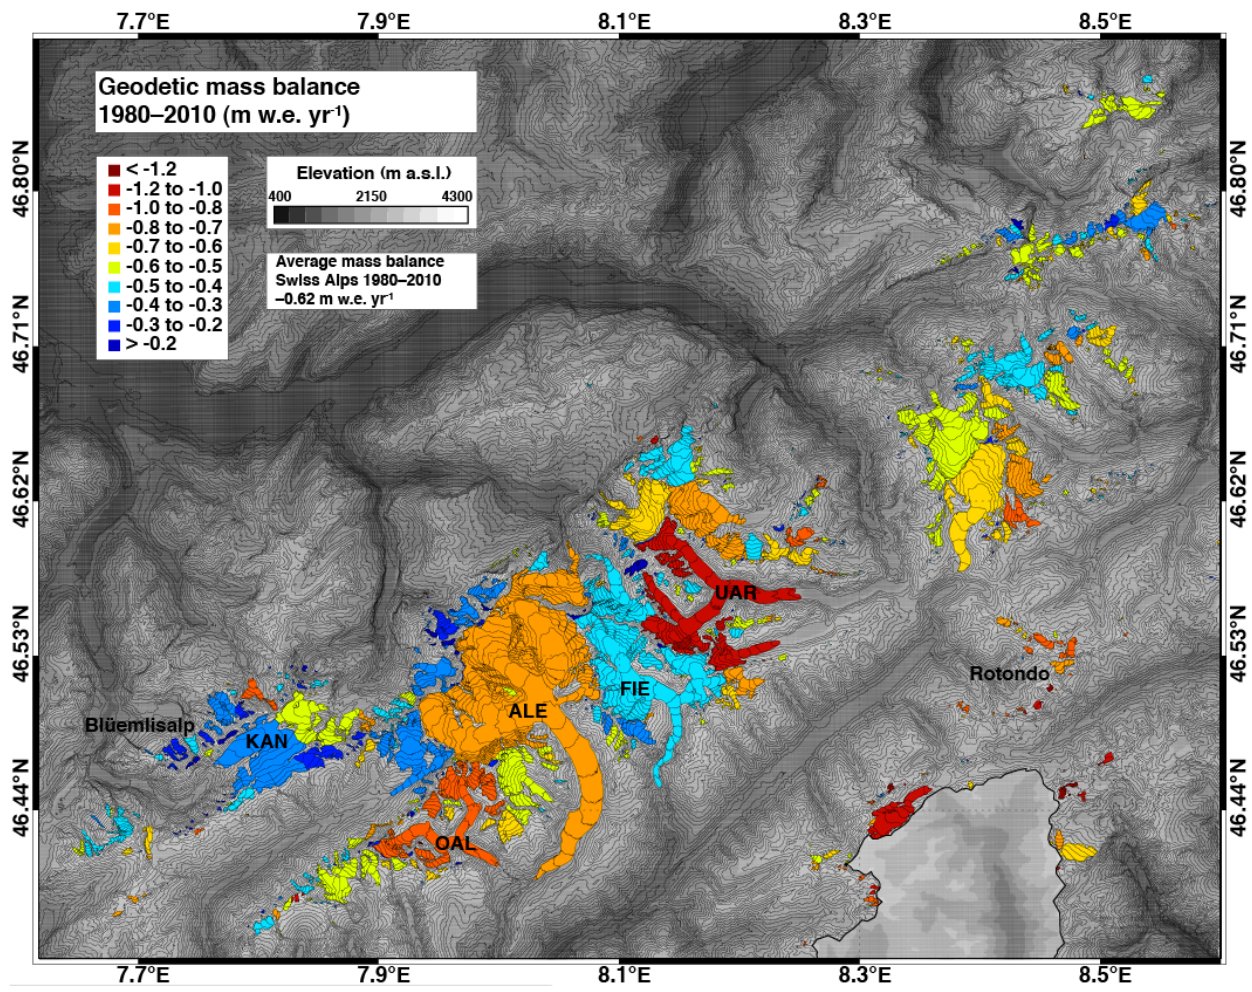
Figure 9. Spatial distribution of the temporally homogenized geodetic mass balance 1980–2010 for the eastern Bernese Alps/western Alps of Central Switzerland. The SGI2010 outlines are taken to illustrate glacier surface